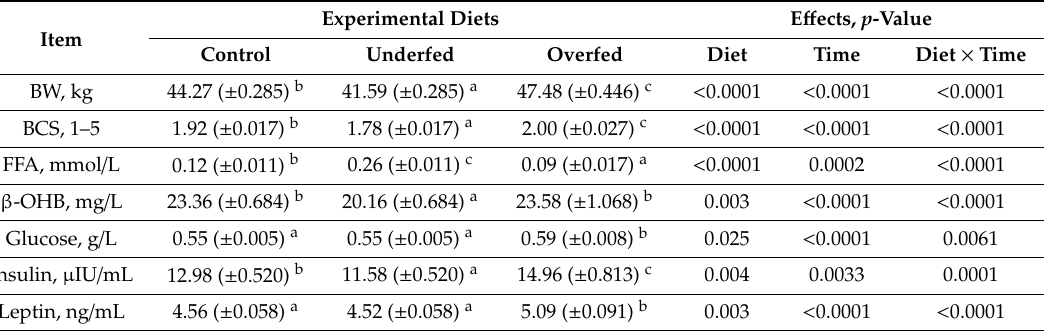
Table 4. Average body weight (BW), body condition score (BCS) and plasma metabolites and hormone concentrations of mature, dry, nonpregnant Merinos d’Arles ewes ( n = 36) receiving 70% (underfed; n = 12), 100% (control; n = 12) or 160% (overfed; n = 12) of their maintenance energy requirements during the dry-o ff period. Values are least-squares (LS) means ± SEM. FFA: free fatty acids and β -OHB: